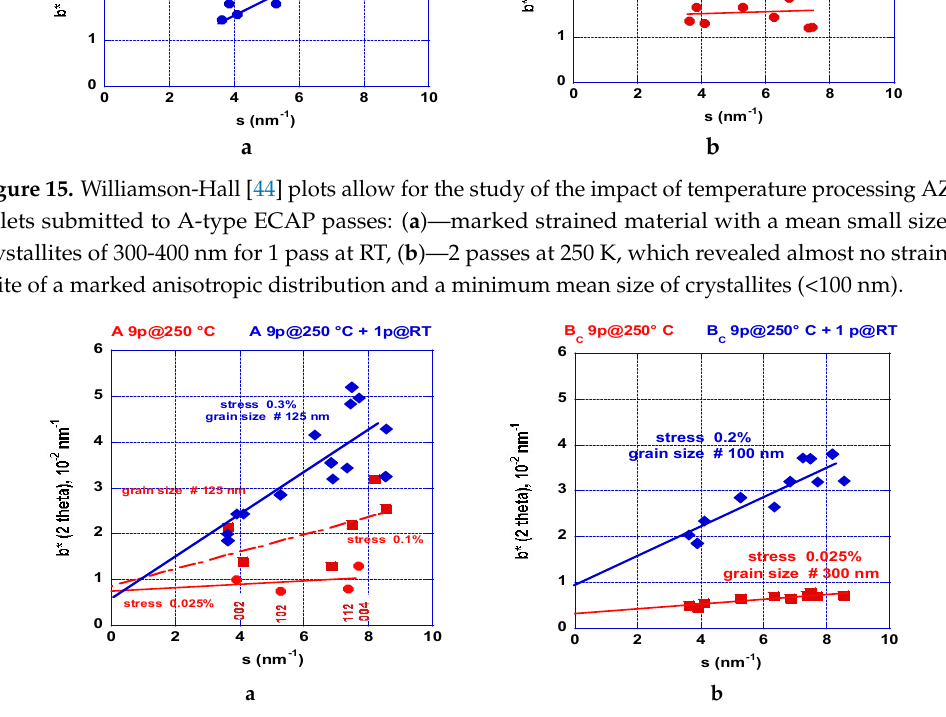
ECAP treatments e.g., at RT, lead to a (re)increase of the level of stresses. Effectively, as shown later,